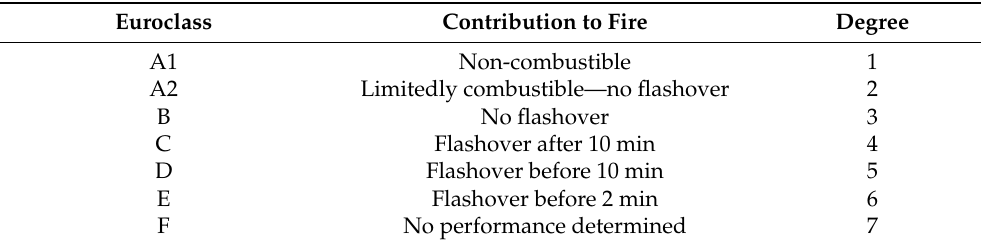
Euroclass Contribution to Fire Degree A1 Non-combustible 1 A2 Limitedly combustible—no flashover 2 B No flashover 3 C Flashover after 10 min 4 D Flashover before 10 min 5 E Flashover before 2 min 6 F No performance determined